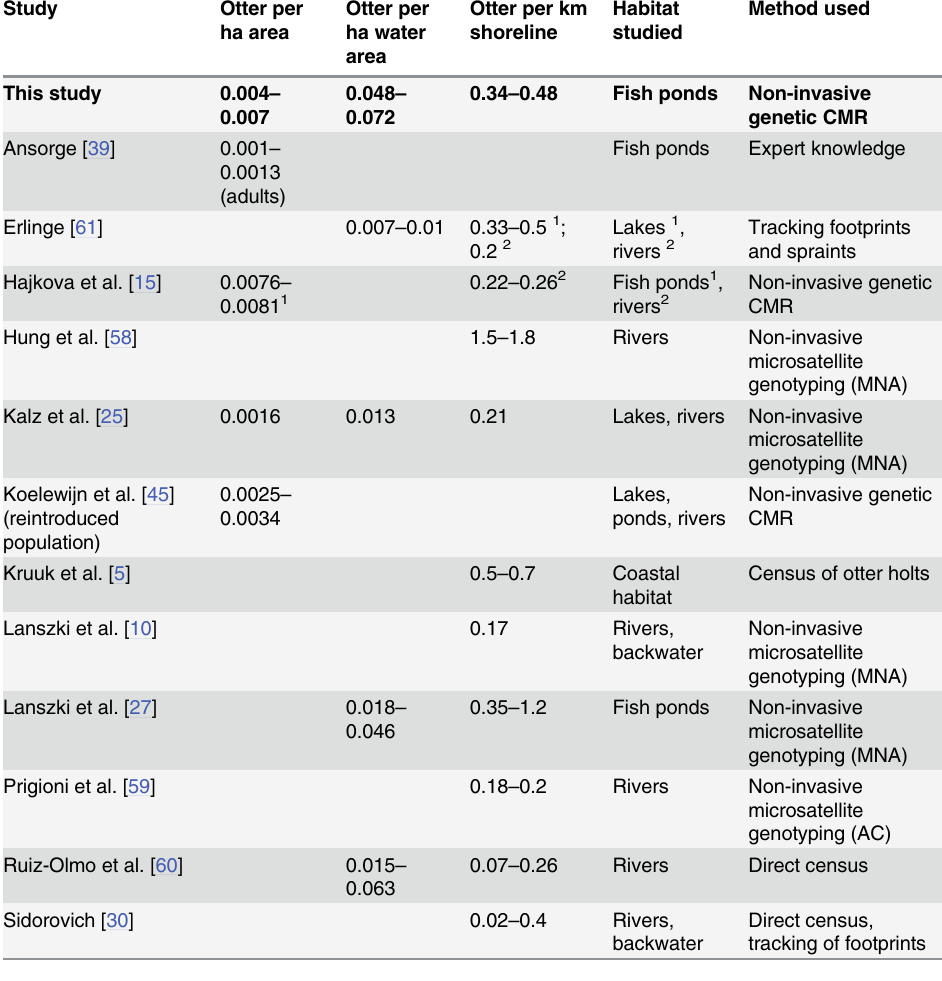
Table 3. Otter densities of different studies including information on studied habitats and on em- ployed methods. Study Otter per ha